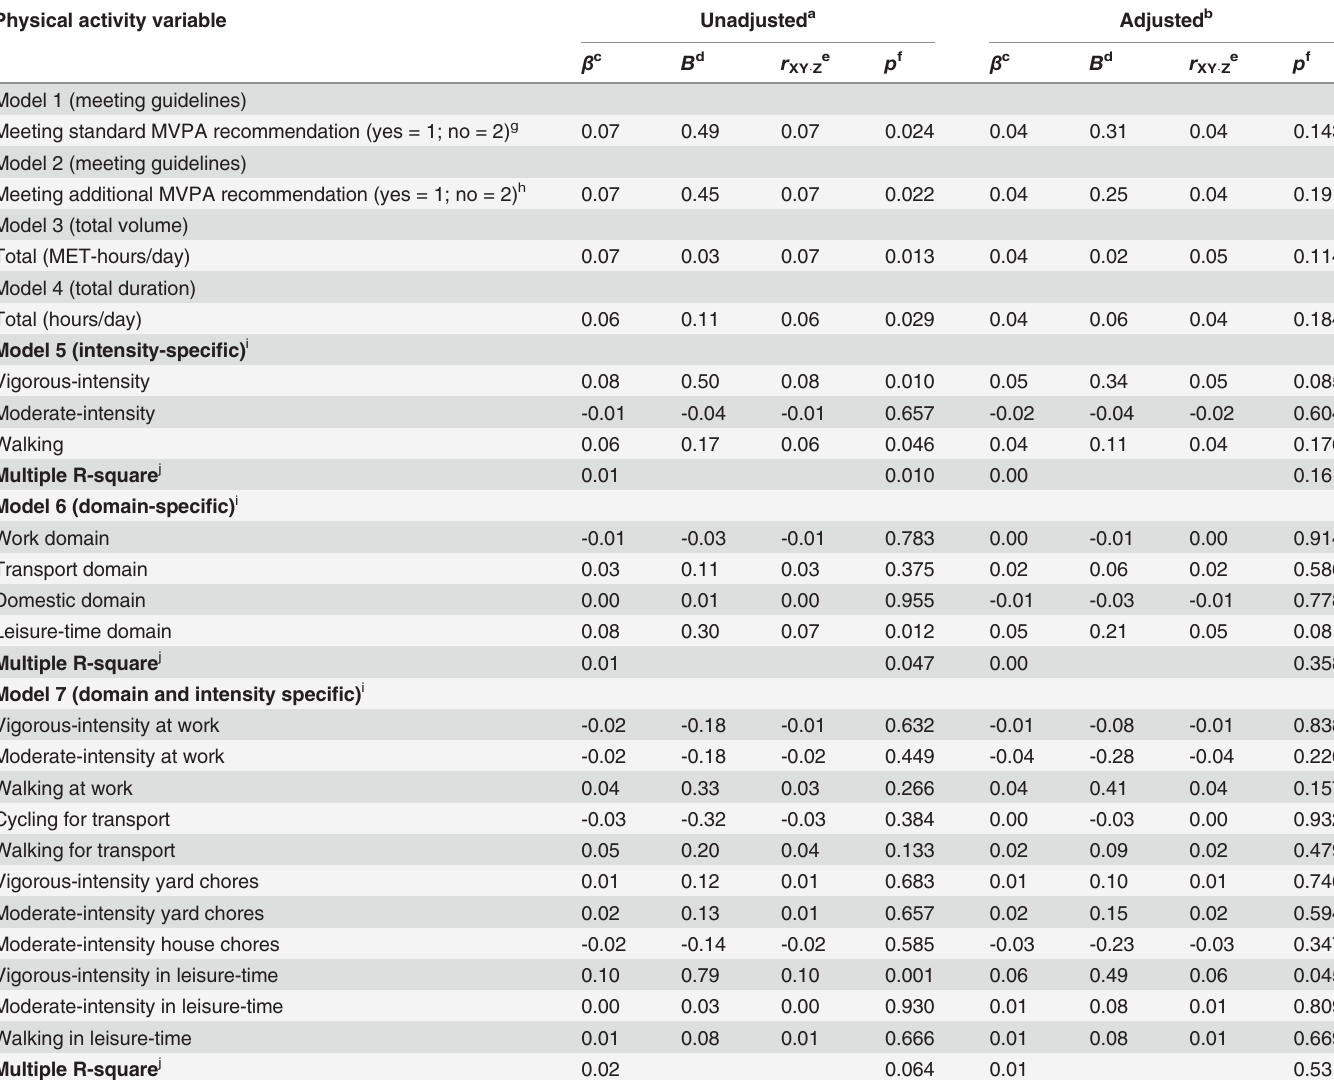
Table 3. Relationship between total, domain- and intensity-speci fi c physical activity levels (independent variables) and life satisfaction (dependent variable) in university